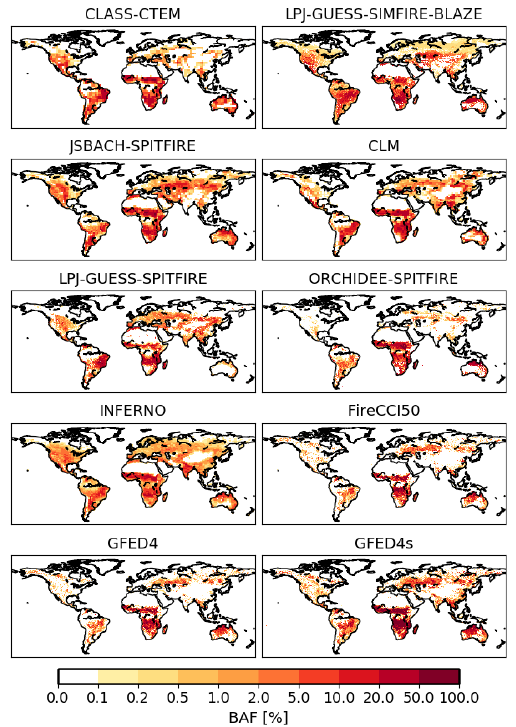
Figure A1. Spatial distribution of annual burned area fraction (BAF) in percent for the baseline experiment SF1 and observation data, averaged over 2001–2013.